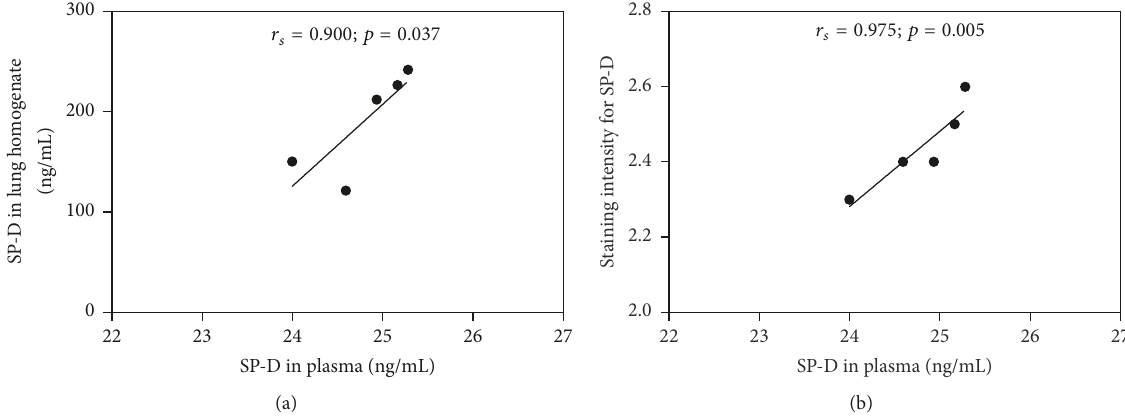
Figure 4: (a) Correlations between SP-D in the plasma and SP-D in the lung homogenate. (b) Correlations between SP-D in the plasma and the staining intensity scores for SP-D in the malaria-infected mice with ALI/ARDS (n = 5). The data were analyzed using Spearman’s rank correlation